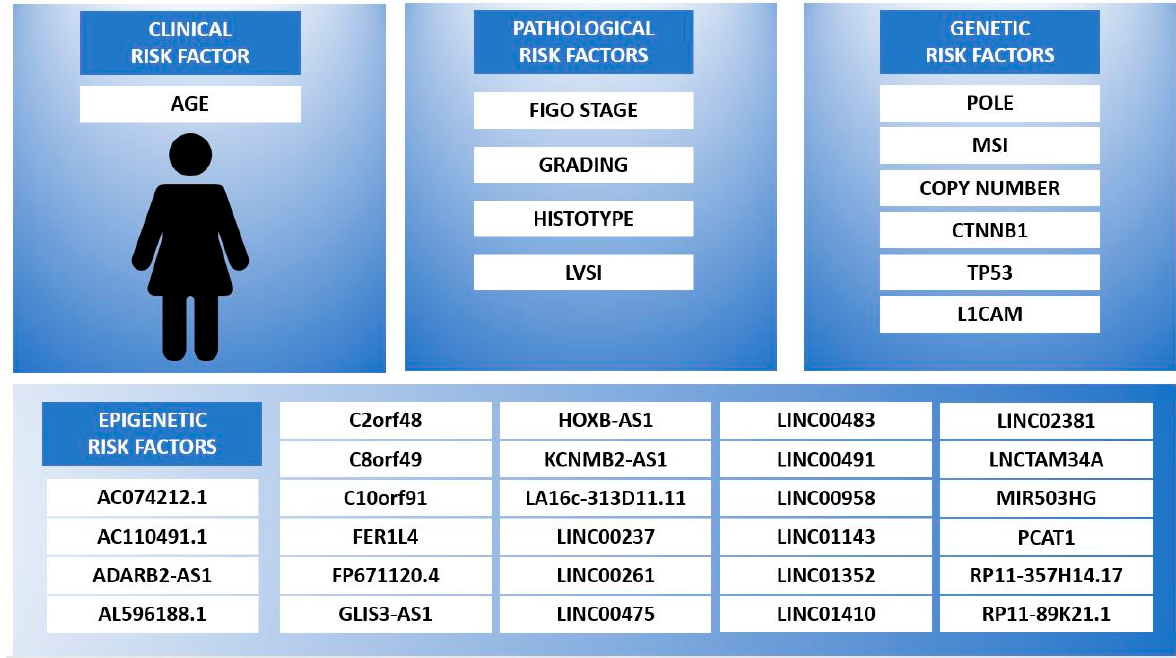
Figure 1. EC patients risk stratification according to clinical, pathological, genetic and epigenetic prognostic factors.